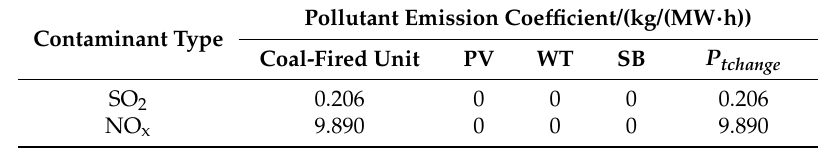
Table 8. Pollutant discharge coefficient of microgrid.